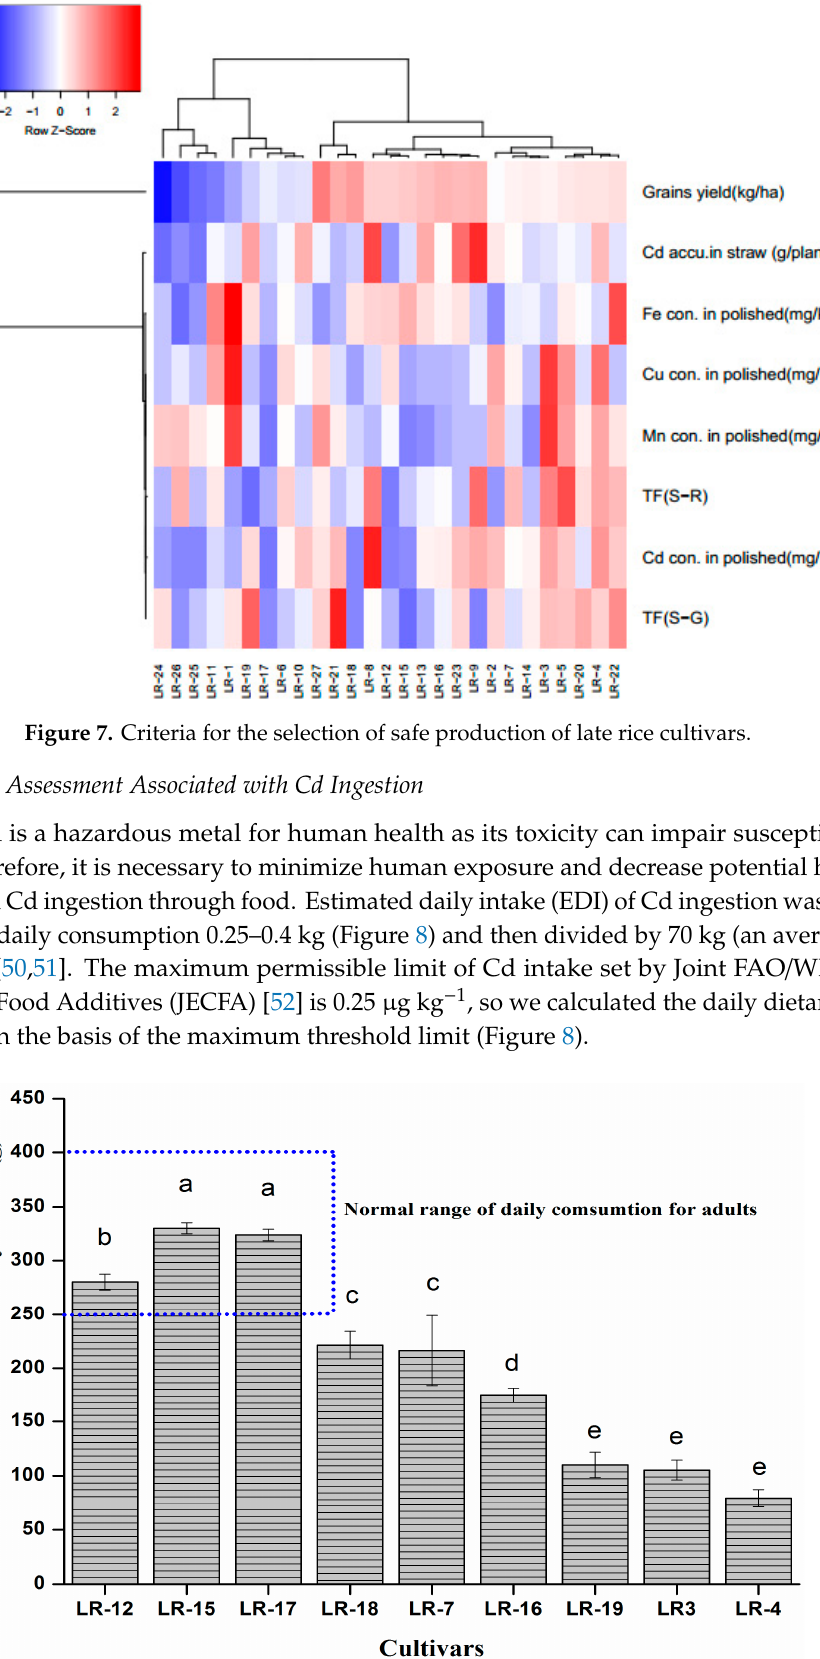
Figure 8. Daily dietary threshold limit of late rice grain on the basis of Cd concentration in polished rice.